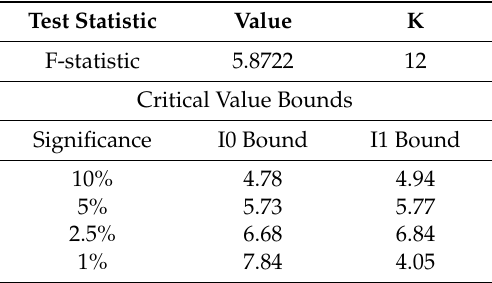
Table 2. Bounds test (null hypothesis: no long-term relationship exists).